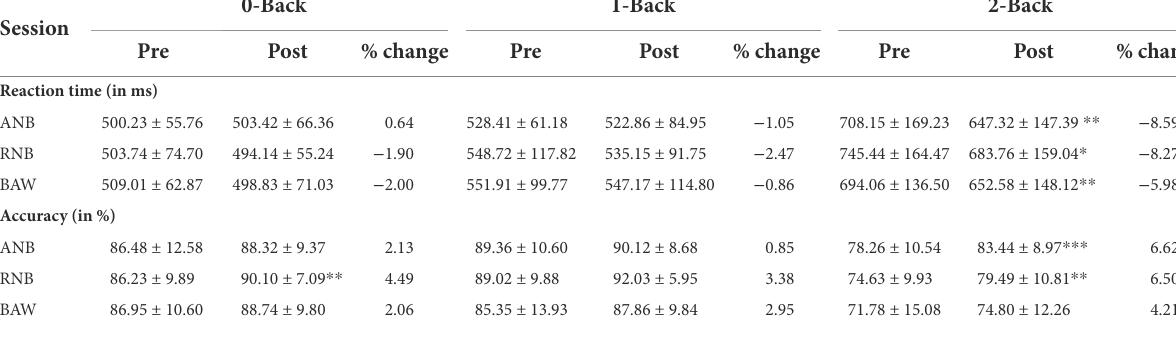
TABLE 1 Effect of yoga breathing on reaction time (ms) and accuracy (%) of n-back task. 0-Back 1-Back 2-Back Session Pre Post % change Pre Post % change Pre Post % change Reaction time (in ms)